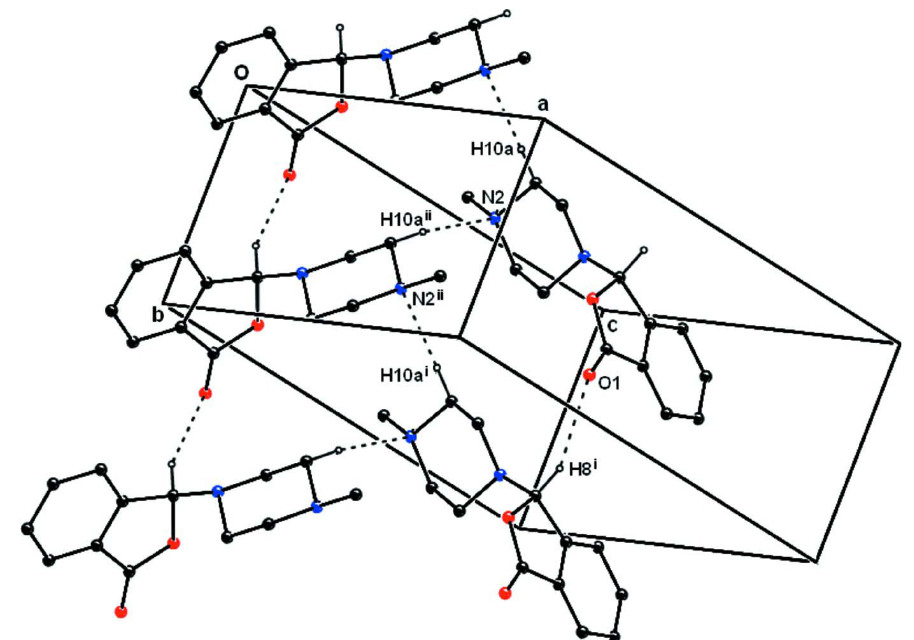
A partial packing diagram of (I), showing the formation of R 33 (17) ring motifs. Hydrogen bonds are shown as dashed lines [symmetry codes: (i) x , y + 1, z ; (ii) 1 - x , 2 - y , 1/2 - z ]. H atoms not involved in hydrogen bondings have been omitted for